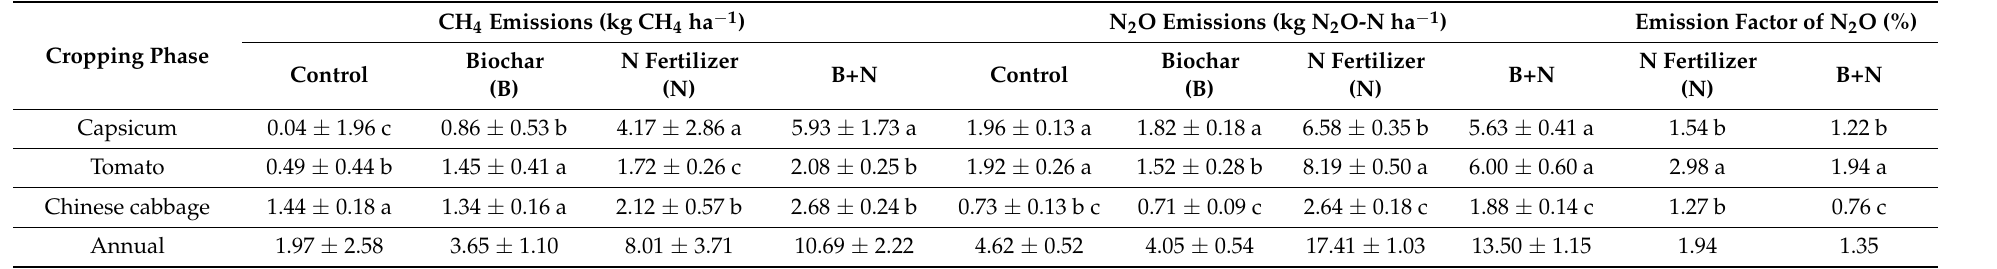
Table 2. Seasonal and annual total of CH 4 and N 2 O emissions and fertilizer N-induced N 2 O emission factors across the annual cropping